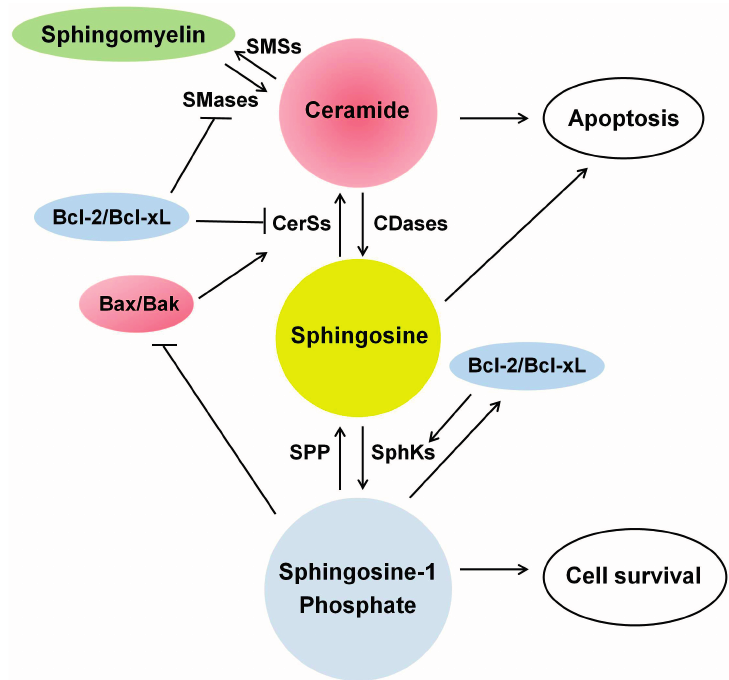
Figure 4. Ceramide, sphingosine and sphingosine-1-phosphate (S1P) and their regulation by Bcl-2 family proteins in apoptosis. Ceramide and sphingosine function as pro-apoptotic factors, while S1P functions as a survival factor. Bcl-2/Bcl-xL activates sphingosine kinases (SphKs), resulting in accumulation of S1P, thereby reducing apoptosis. Bcl-2/Bcl-xL suppresses CerSs and SMases, reducing ceramide accumulation and apoptosis. In contrast, Bax/Bak increases CerSs activity, thereby enhancing ceramide accumulation and apoptosis. S1P prevents apoptosis by reducing the expression and activity of Bax/Bak